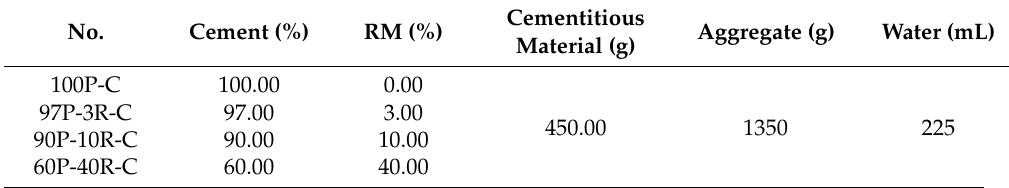
Table 2. The mix design proportions of concrete prepared with RM (by weight). No.